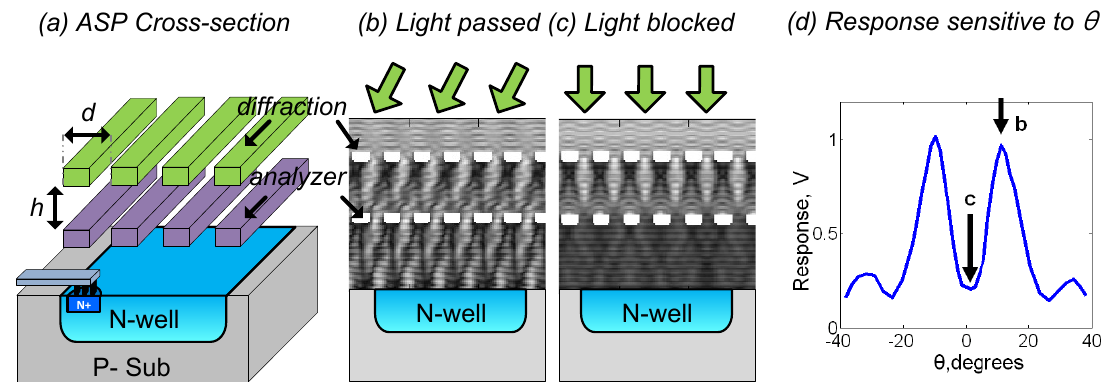
Figure 2. ( a ) Structure of simple angle sensitive pixel (ASP) [17] showing metal gratings and photodiode, grating pitch, d is order 1 µm, while vertical separation, h is order 3 µm, ( b , c ) finite-difference time-domain (FDTD) simulation of field intensity in response to incident plane waves of light: ( b ) diffraction pattern from top grating aligns with gaps in bottom grating, light passes, ( c ) pattern aligns with bars, light is blocked. ( d ) simulated intensity at detector as angle is swept. FDTD simulation is performed using MATLAB. Inter connect metal gratings (Al) is modeled as perfect electrical conductor (PEC) and the inter dielectric layer (SiO 2 ) is assumed lossless. The incident angle of the plane wave are